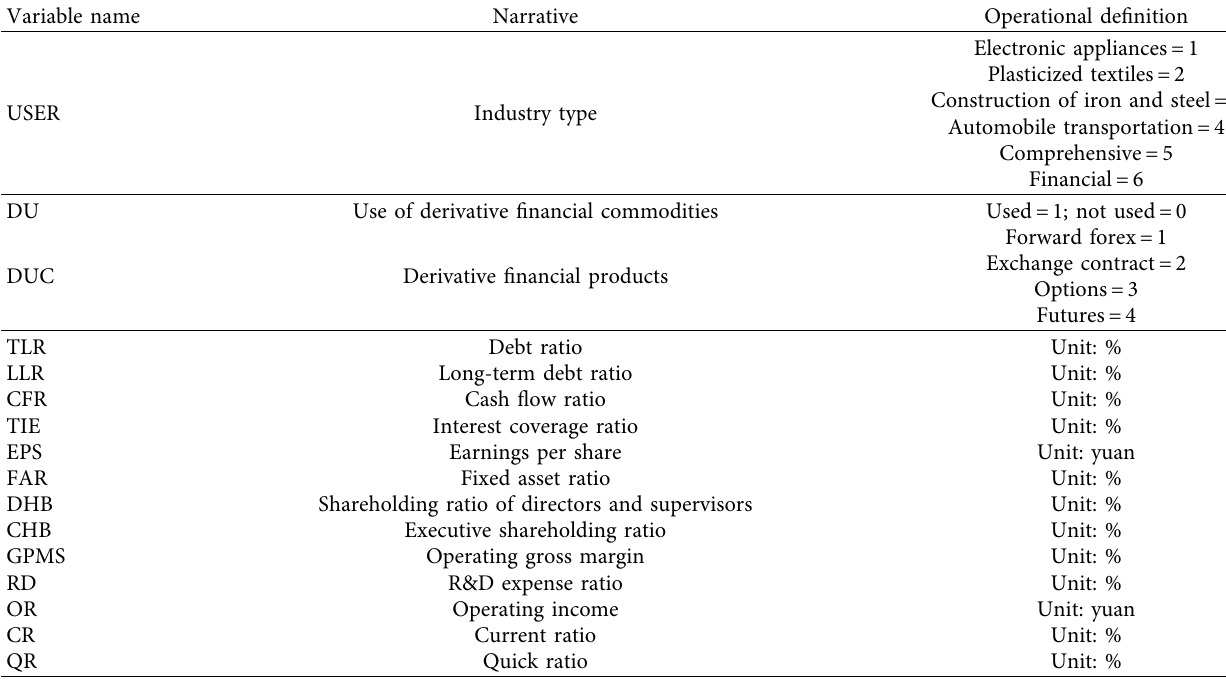
Table 2: Operational definition of each